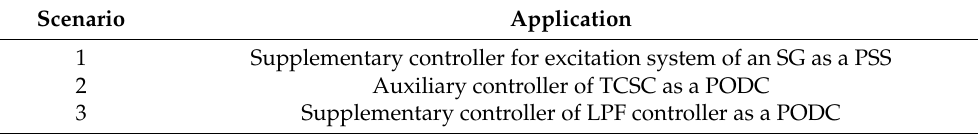
Table 3. Three scenarios for the FOPID controller in a power system as a PODC, based on the literature. Scenario Application